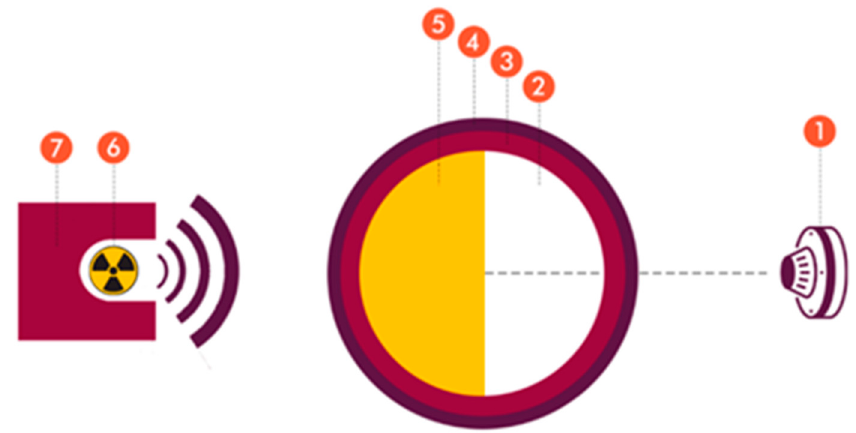
Figure 2. Simulated detection system: (1) NaI detector; (2) gas phase; (3) formed scale; (4) steel pipe; (5) liquid phase; (6) dual-energy source; (7) shield.